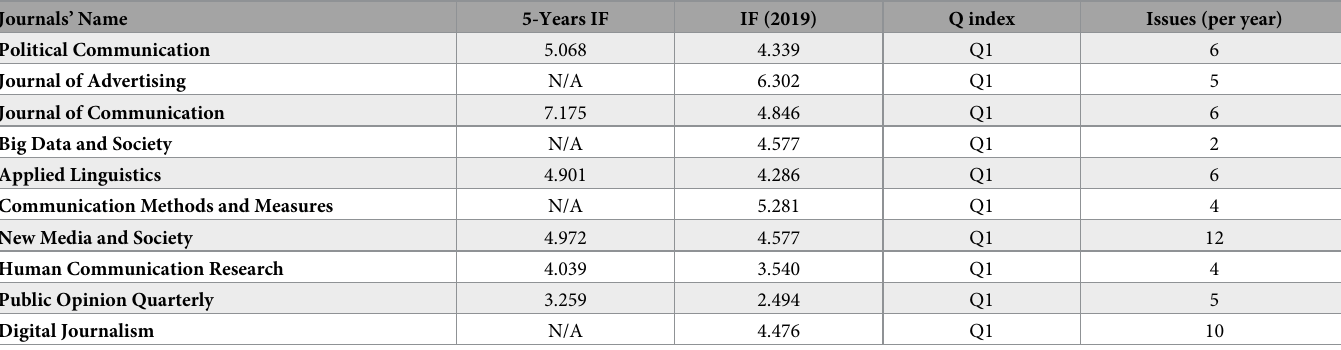
Table 1. The characteristics of